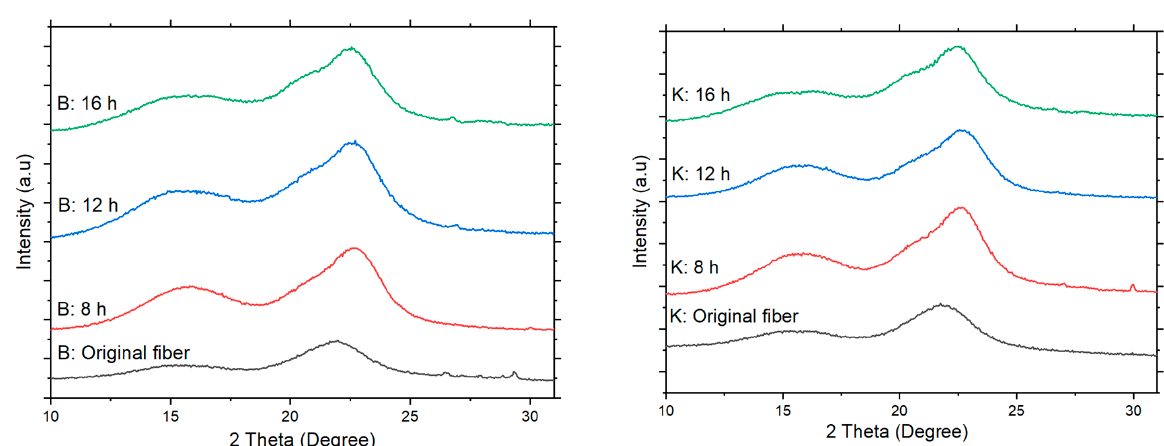
Figure 5. X-ray diffraction (XRD) patterns of the ( left ) balsa fiber and ( right ) kapok fiber and the resulting CNCs.